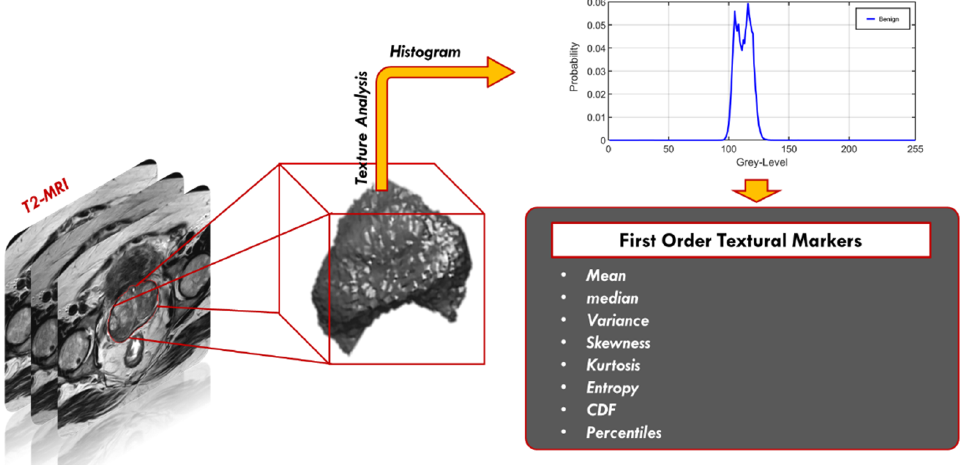
Figure 5. First-order textural features extraction.